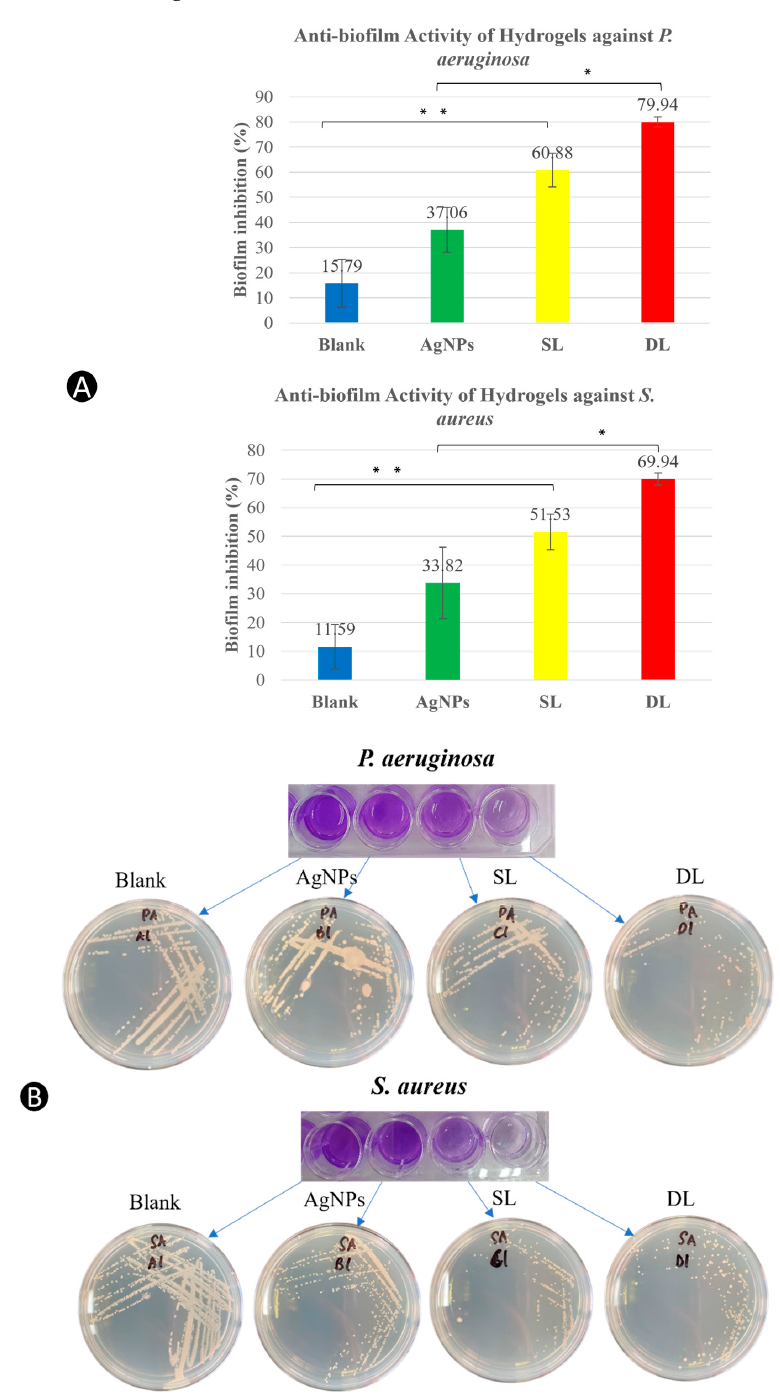
Figure 10. ( A )Anti-biofilm test of blank, AgNPs, SL, and DL gels using the crystal violet assay, n = 4, and ( B ) Image of live bacteria in formed biofilms on MHA plates after treatment with the blank (A1), AgNPs (B1), SL (C1), and DL (D1) gels, n = 3. * statistically significant difference from the blank gel ( p < 0.05); ** statistically significant difference from the DL gel ( p < 0.05).